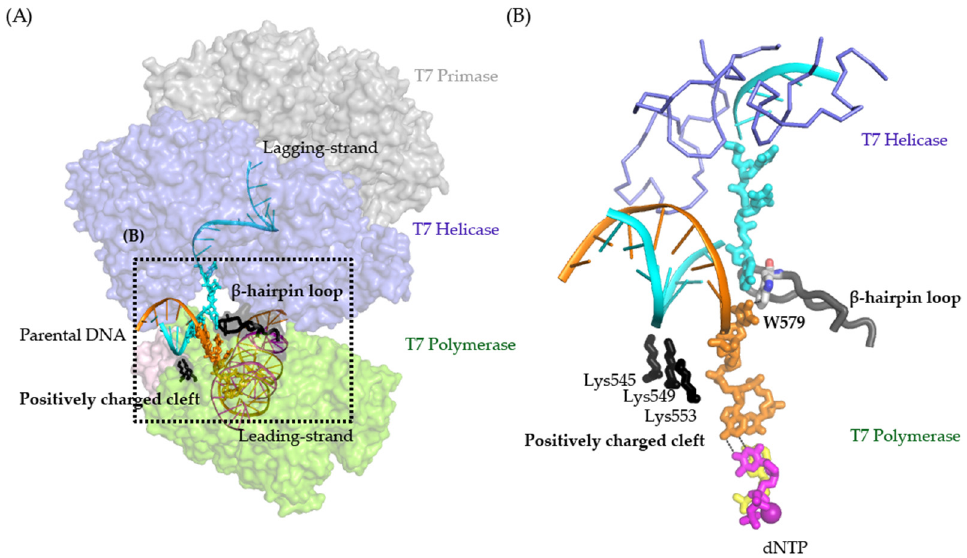
Figure 1. ( A ) Structure of T7 replisome on a DNA fork. The polymerase, helicase, and primase are colored green, blue, and grey, respectively. The positively charged cleft and β -hairpin loop of the T7 Polymerase are shown as black cartoons. The charged–charge interactions between the helicase and polymerase are indicated by pink and blue symbols. ( B ) Zoomed-in view of the DNA fork bound by the T7 polymerase and the helicase. The β -hairpin and the positively charged cleft (Lys545, Lys549, and Lys553) are depicted as a grey cartoon and black